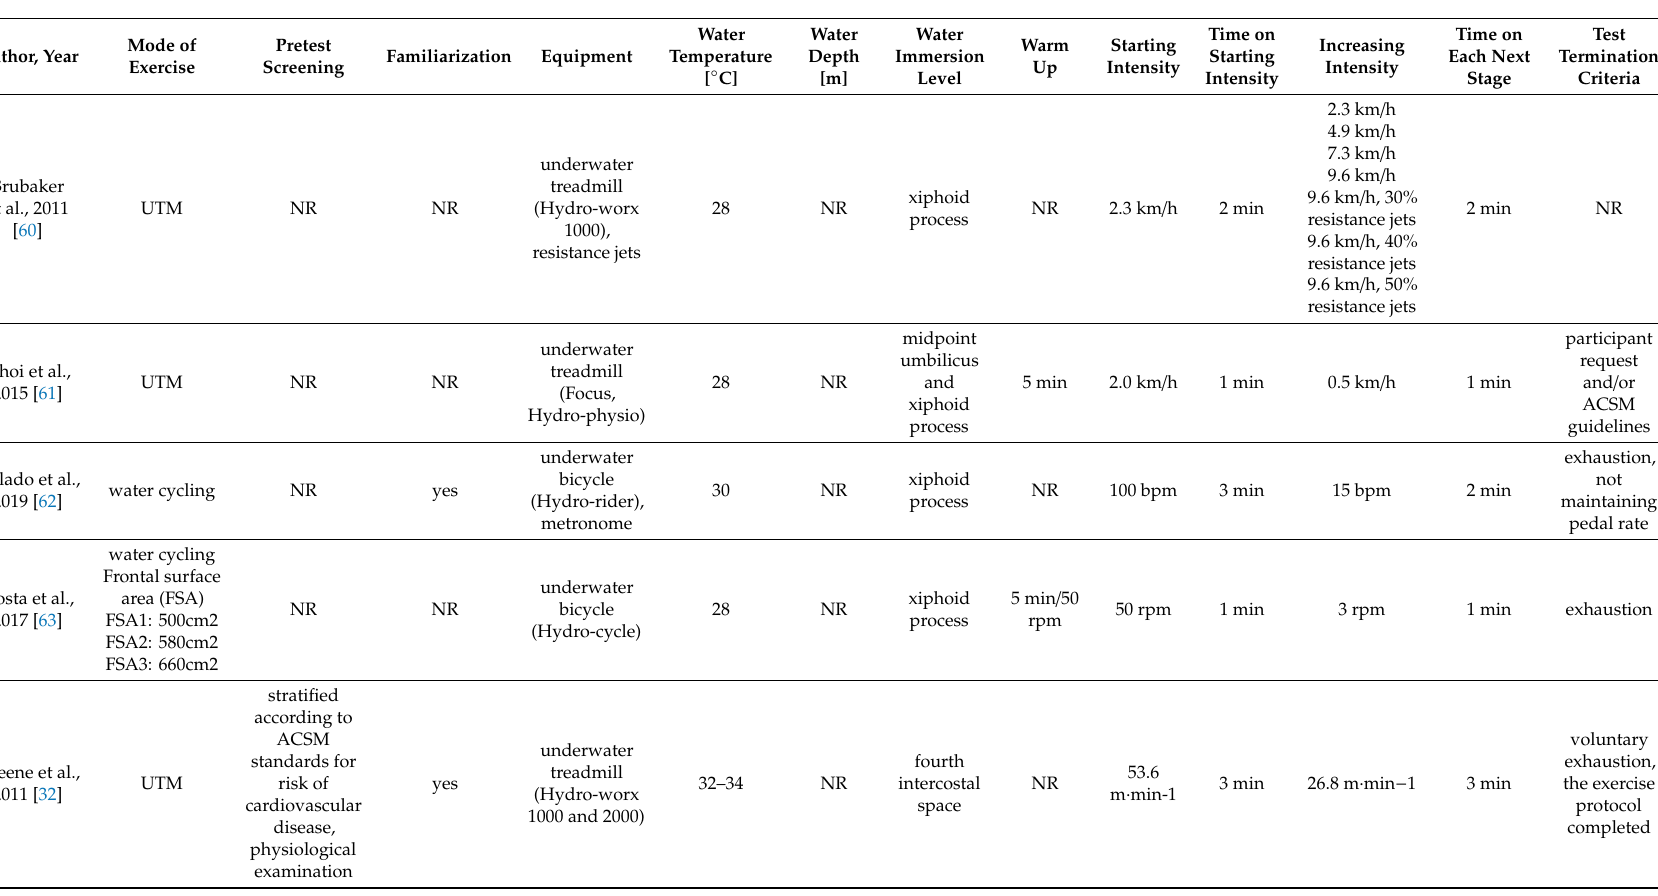
Table 3. Test protocols with special